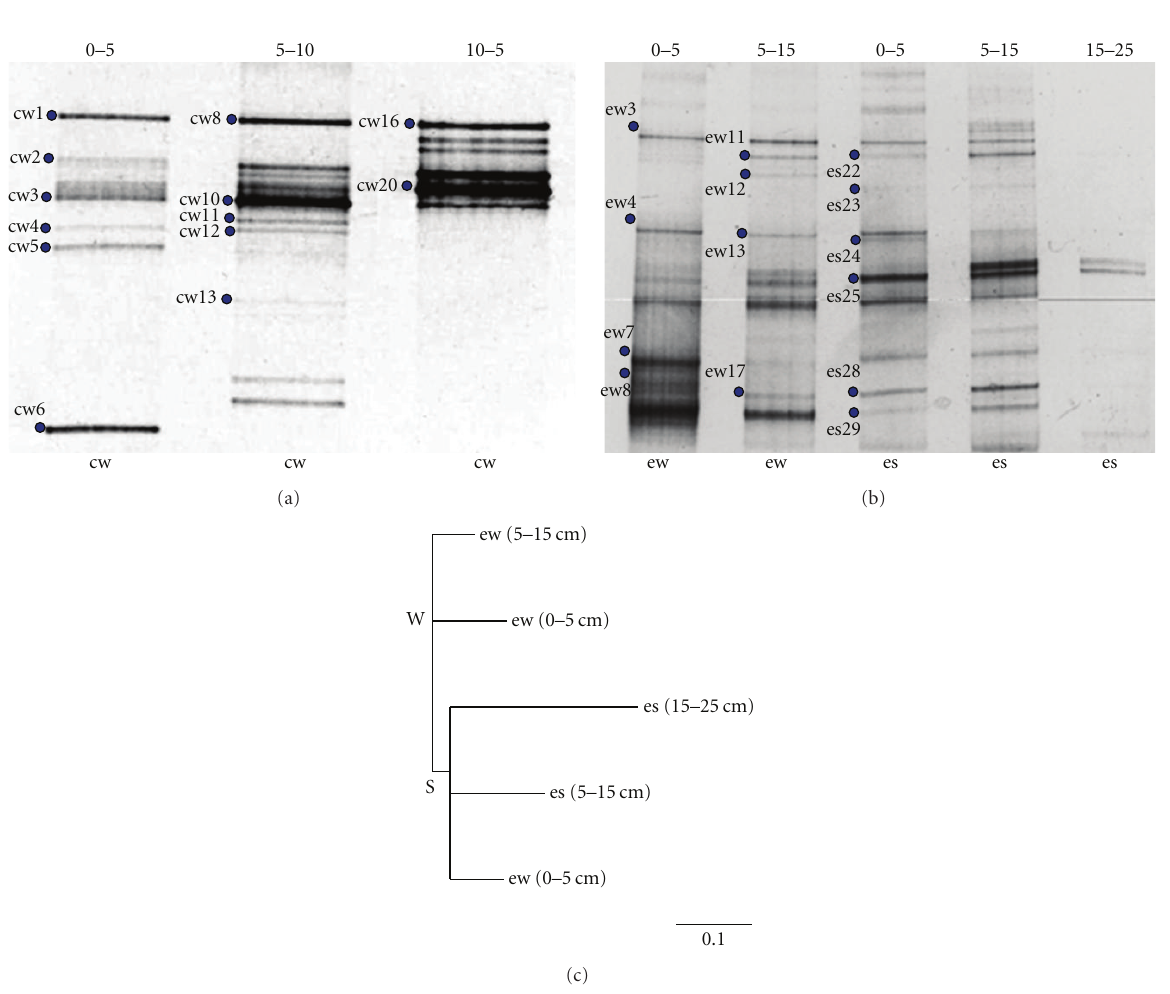
Figure 3: DGGE pattern of PCR-amplified aprA gene fragments from nonaxenic SRP cultures (a) and sediment samples (b). (a) series of DGGE patterns obtained from nonaxenic cultures inoculated from winter sediment (cw); (b) Series of DGGE patterns obtained from environmental samples: winter (ew) and summer (es) obtained from di ff erent depths (cm). The aprA gene fragment from 15–25 cm depth (winter) was not amplified. (c) Maximum Likelihood cluster analysis of the B-pattern DGGE profile the scale bar represents expected numbers of base